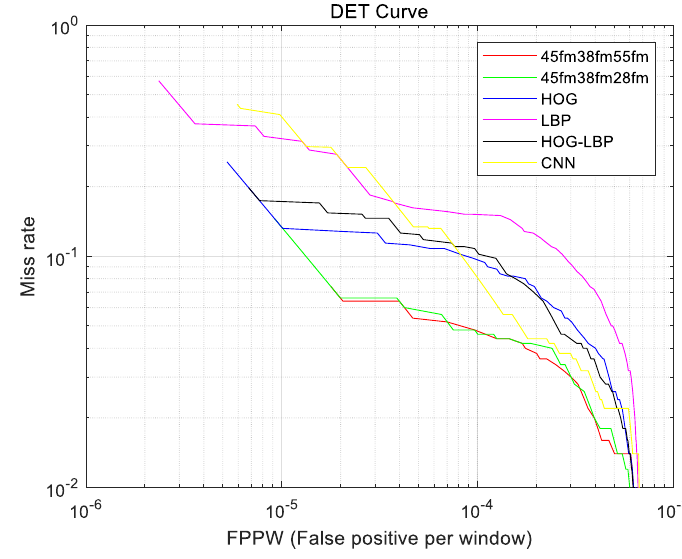
Figure 16. Proposed and conventional vehicle detection framework performances.